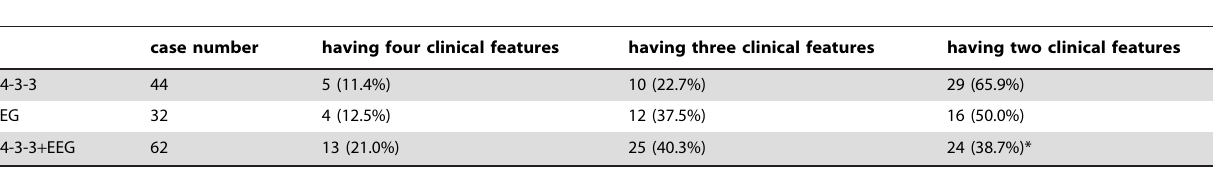
Table 5. The frequencies of other four clinical manifestations except progressive dementia in 138 probable sCJD patients with two